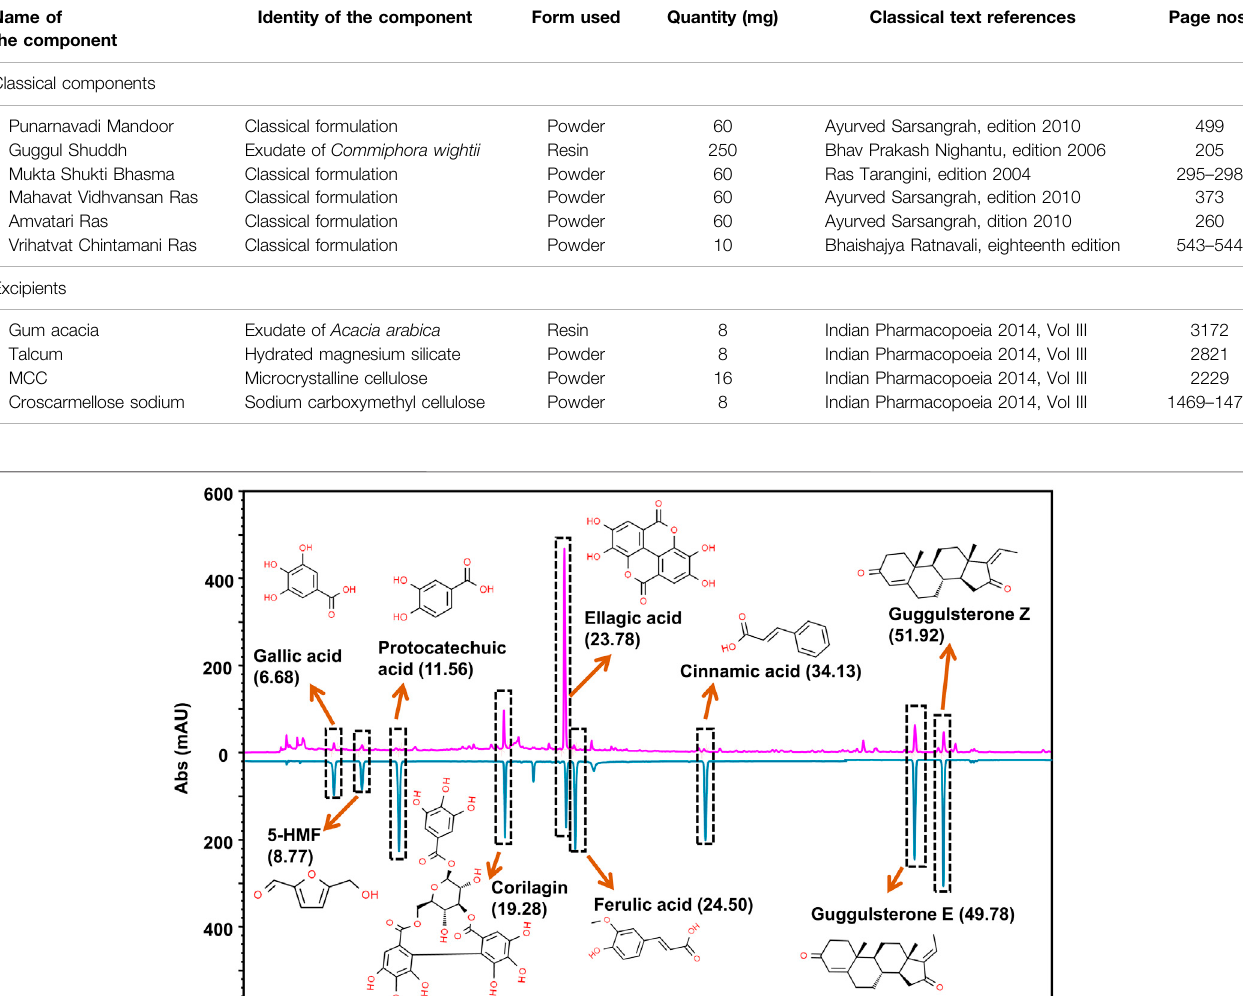
Frontiers in Pharmacology |